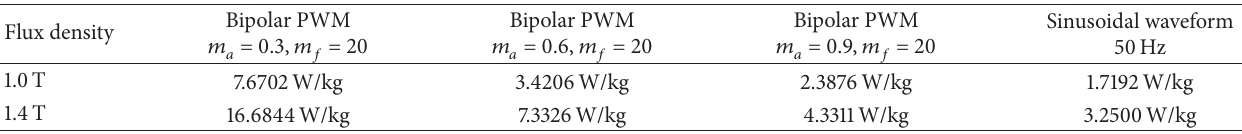
Table 4: Iron losses for a sinusoidal waveform and bipolar PWM (with 𝑓 = 50 Hz) obtained using the new toroidal frame. Flux